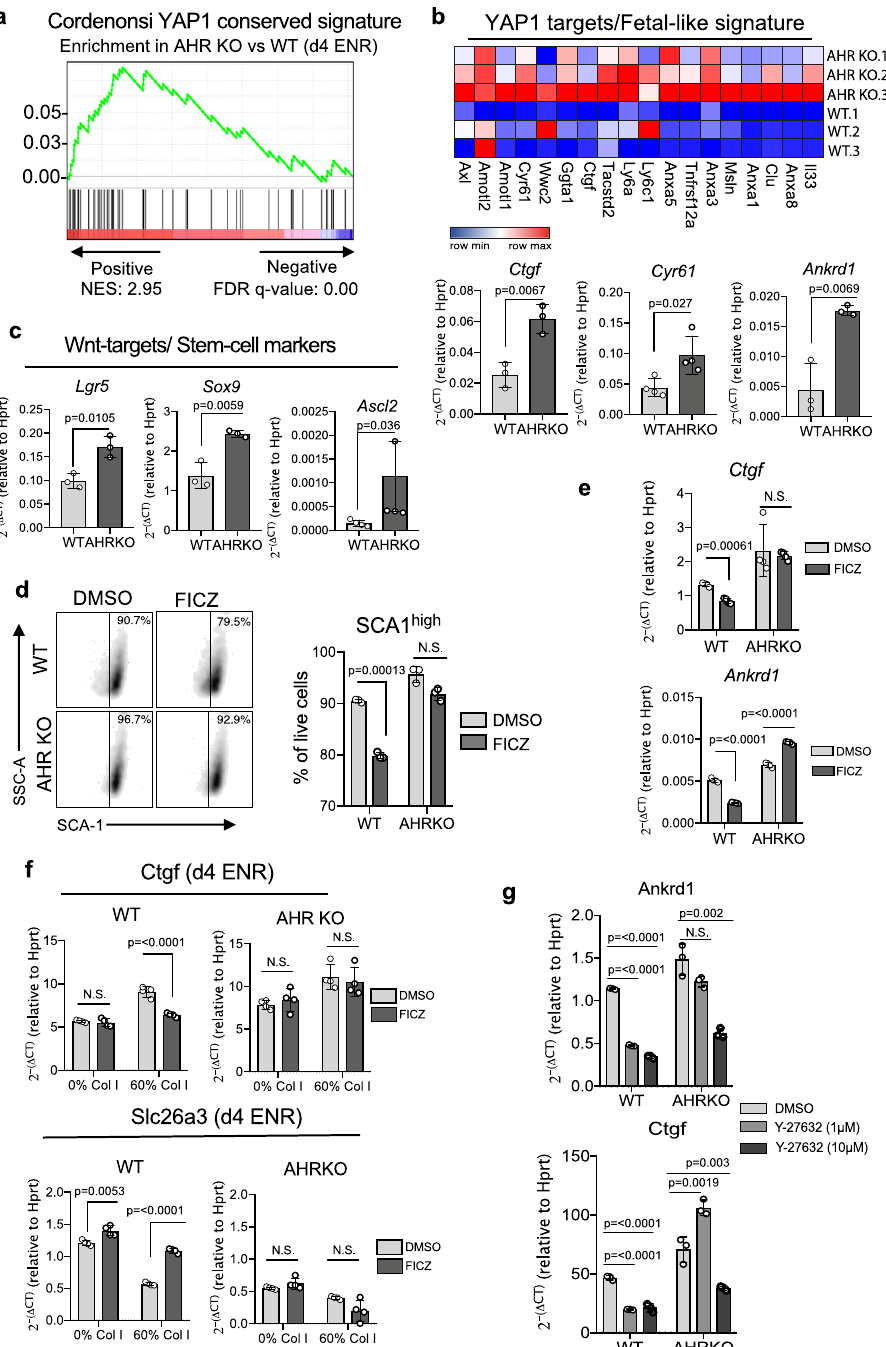
Fig. 3 Enrichment for Yap/Tead targets in d4 ENR AHR KO organoids. a Enrichment plot for transcriptional signature of d4 ENR AHR KO organoids compared to the Cordenonsi Yap1 conserved signature dataset (GSEA C6: Oncogenic datasets - NES: 2.95, FDR q value: 0.00) ( b ) Heatmap of select Yap1 targets and fetal-like genes differentially expressed in d4 ENR AHR KO organoids; expression of YAP1 target Ctgf , Cyr61 and Ankrd1 validated by qPCR. c expression of Lgr5 , Ascl2 and Sox9 by qPCR. d Representative fl ow cytometry plots and percentage of cells expressing high levels of surface Sca-1 ( e ) qPCR expression of Yap targets in WT and AHR KO organoids in WENR conditions after 24h and 4h of FICZ-stimulation, respectively. f qPCR expression of Ctgf and colonocyte differentiation marker Slc26a3 in organoids grown in matrigel containing either 0% or 60% Collagen I. Cells were stimulated with either DMSO (vehicle) or FICZ and expression was assessed 24h post-treatment. g qPCR expression of Ctgf and Ankrd1 in WT and AHR KO organoids grown in 60% Collagen I (d4 ENR) treated with either 1 µ M or 10 µ M of ROCK-inhibitor (Y-27632). Organoids used for experiments were generated from either n = 3 (i.e. Lgr5 , Sox9 , Ankrd1 , Ctgf ) or n = 4 (i.e. Cyr61 , Ascl2 ) mice per genotype. Data-points for the collagen and Y-27632 experiments are generated from n = 4 and n = 3 mice per genotype respectively. Statistical signi fi cance was determined by ( a , b ) unpaired t -test (two-tailed) ( c – f ) two-way ANOVA with Sidak ’ s multiple comparison test, ( g ) statistical differences between treatment and DMSO control per genotype was done using an ordinary one-way ANOVA with Dunnett ’ s multiple comparison test. P value of >0.05 was considered not signi fi cant (n.s.). Error bars displayed on graphs represent the mean± SD of at least two independent experiments. Source data for (3 b – g ) are provided with this paper in the source data fi